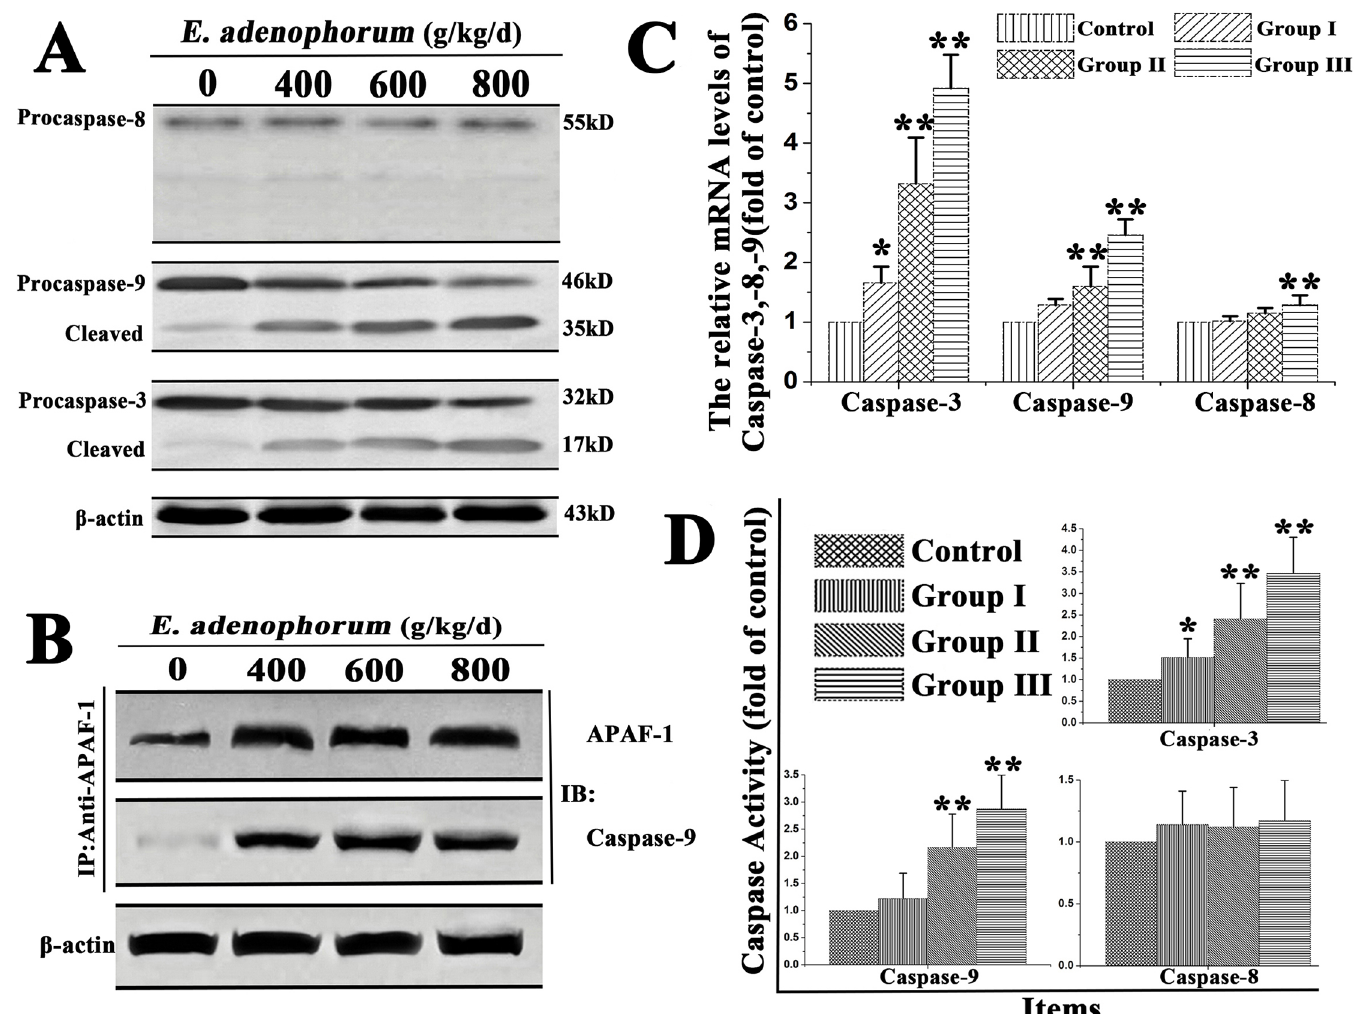
Fig 3. E . adenophorum -induced apoptosis is mediated by activation of caspase-9, caspase-3. (A) The protein levels of procaspase-3, -8, -9 and the cleaved form of them. The expression of apoptosis-related proteins, including caspase-3, -9, -8 were shown with β -actin as a control, were detected by Western-blot analysis. (B) E . adenophorum induced apoptosome formation. Protein extractions from renal cells were collected and then used in immunoprecipitation assays against Apaf-1. The level of caspase-9 was detected by western blot to indicate the formation of apoptosome complex. (C) The relative mRNA levels of caspase-3, -8 and -9. The Saanen goat was treated with different dose of E . adenophorum for 3 months and the mRNA of renal cells was extraced and used for qRT-PCR assay. E . adenophorum induced the activiation of caspase-3, -9. (D) Caspase activities in renal cells. BCA assay was used to equal protein amounts and the enzymatic activities of caspases-8, -9, and -3 were measured using the colorimetric assay kits. Data are presented with the means ± SD and mean values of three independent experiments. * p < 0.05 and ** p < 0.01, compared with the control